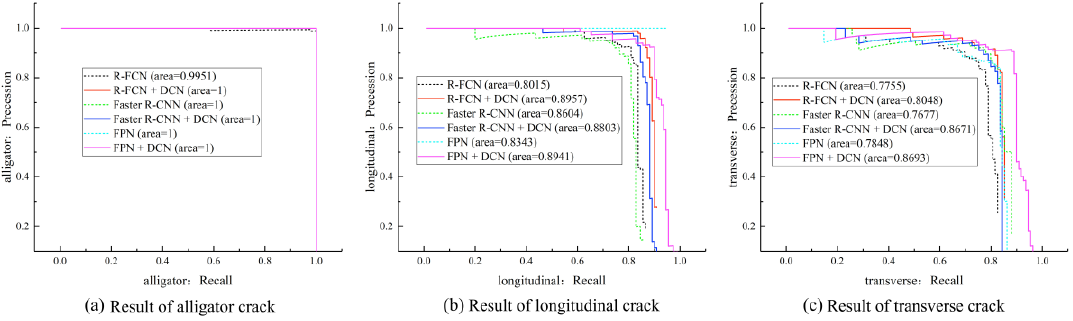
Figure 13. PR curves of the models under their optimal